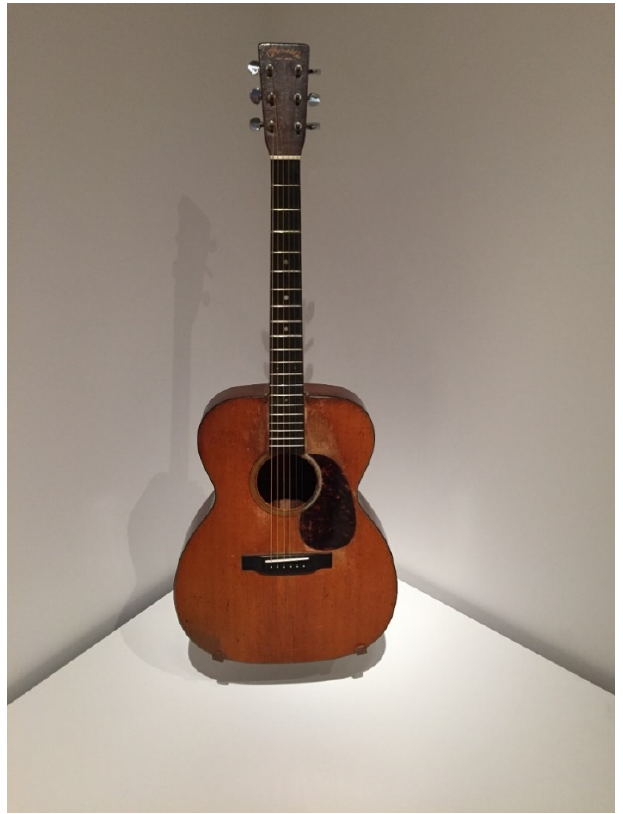
Figure 1. T.C. Cannon’s 000-18 Martin Guitar, as displayed at PEM, T.C. Cannon: At the Edge of America . Photograph by Philip J. Deloria.